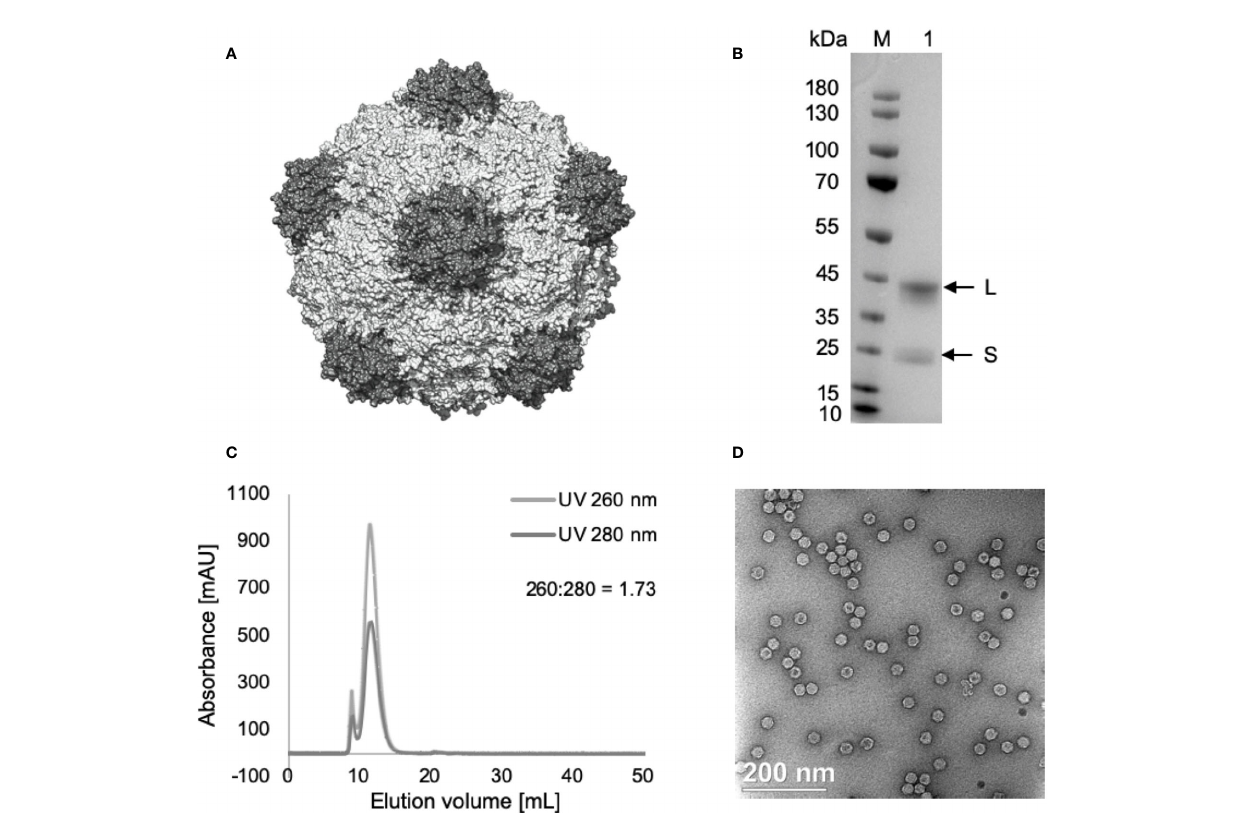
FIGURE 1 | Cowpea mosaic virus (CPMV) particle structure and characterization. (A) Structure of CPMV, created using UCSF Chimera, using PDB entry 1ny7. (B) SDS-PAGE, 4% – 12%, 200 V, 40 ’ . Lane M: PageRuler Prestained Protein Ladder, lane 1: 5 µg CPMV. L (42 kDa) and S (24 kDa) coat proteins marked by arrows. (C) Size-exclusion chromatography of puri fi ed CPMV using Superose 6 10/300 column on GE Äkta ™ Pure. (D) Transmission electron micrographs of uranyl acetate stained CPMV, 35,000x